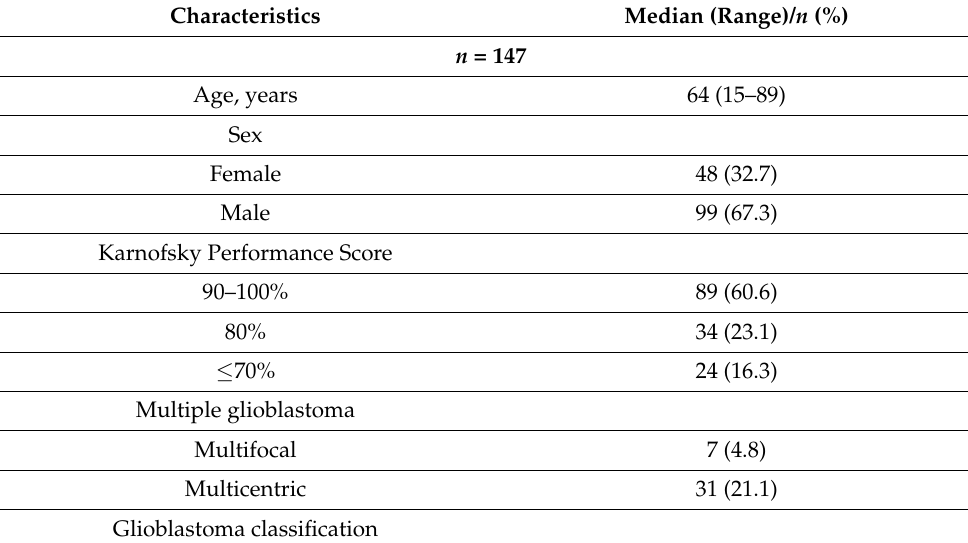
Table 1. Patient, tumor and treatment